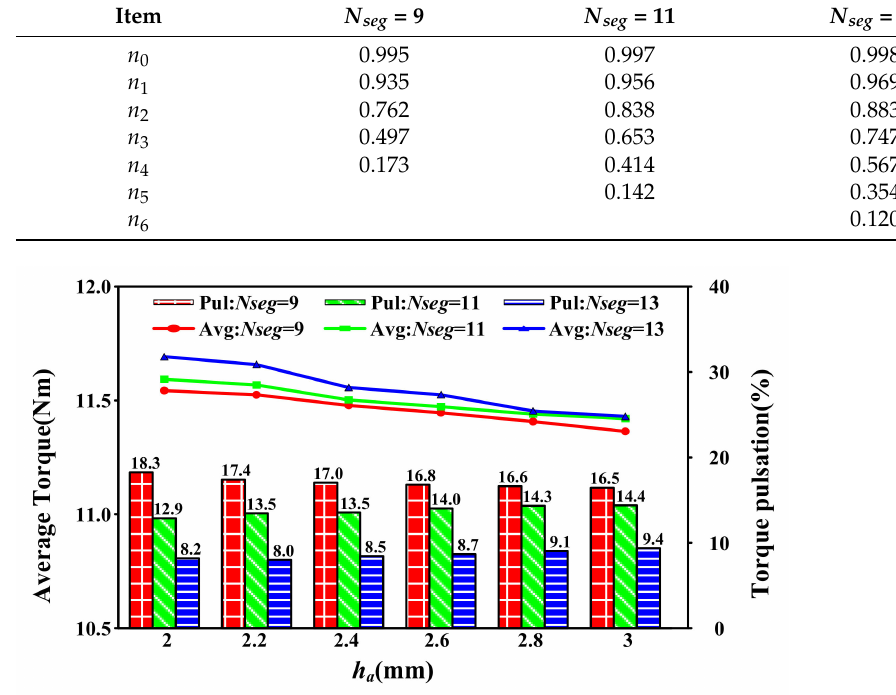
Figure 5. Average torque and torque pulsation of stairs vary with h a